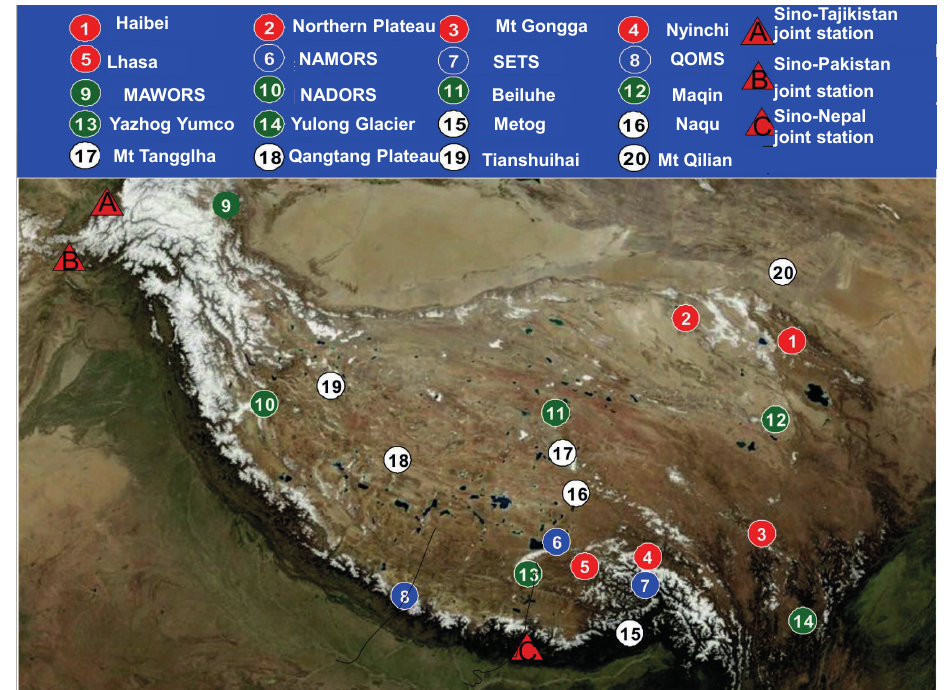
Fig. 1 The station layout in the TPE